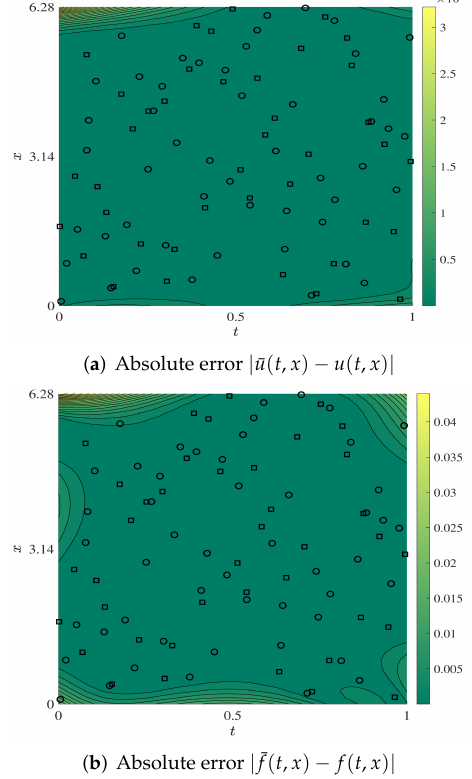
Figure 2. High-order partial differential equation: prediction error for u ( t , x ) and f ( t , x ) .